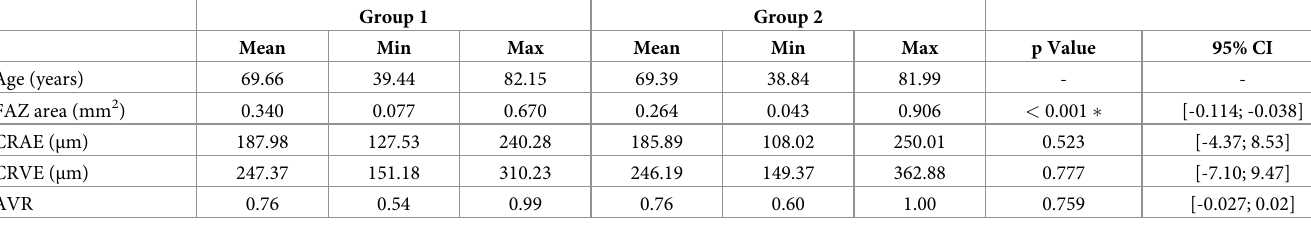
Table 2. Summary of fluorescein angiography measurements for Group 1 and Group 2.